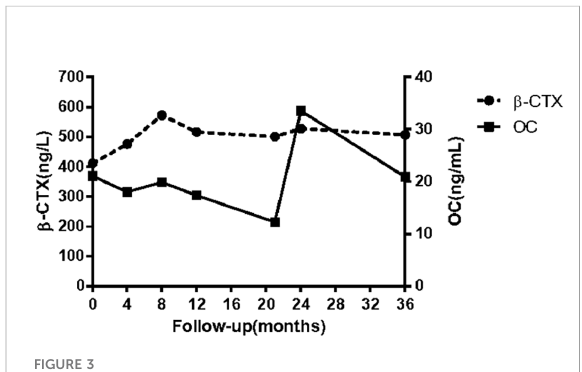
FIGURE 3 Bone turnover markers during treatment (alendronate orally at the beginning of treatment; a single infusion of intravenous zoledronic acid by the 12th month; right femur fracture by the 14th month; atypical fracture of left femur by the 20th month; menatetrenone orally by the 21st month). b -CTX: b -isomerized C-terminal telopeptide of type I collagen; OC: serum osteocalcin in the form of an N-terminal mid-molecule